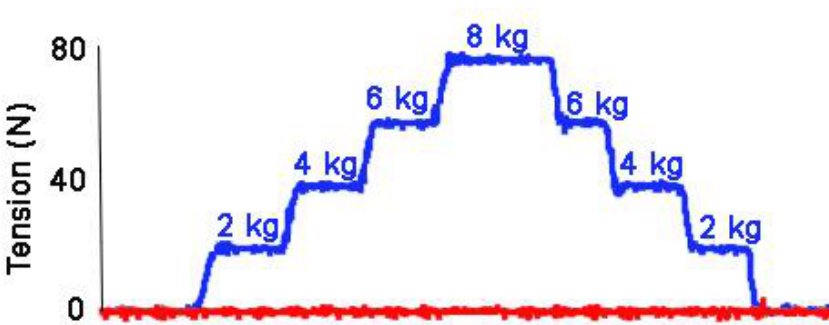
Figure 6. Calibration of a transducer by hanging weights of 2, 4, 6, 8, 6, 4, and 2 kg from the transducer and recording the output voltage which is converted to Newtons. In this example weights were added to the right rein at intervals of 10 s and removed at intervals of 6–8 s, Red: right rein; blue: left rein.